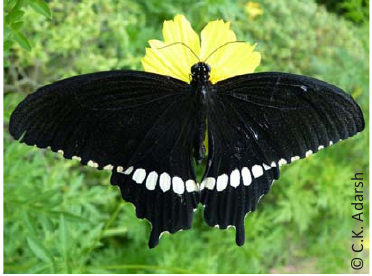
Image 11. Papilio polytes Common Mormon